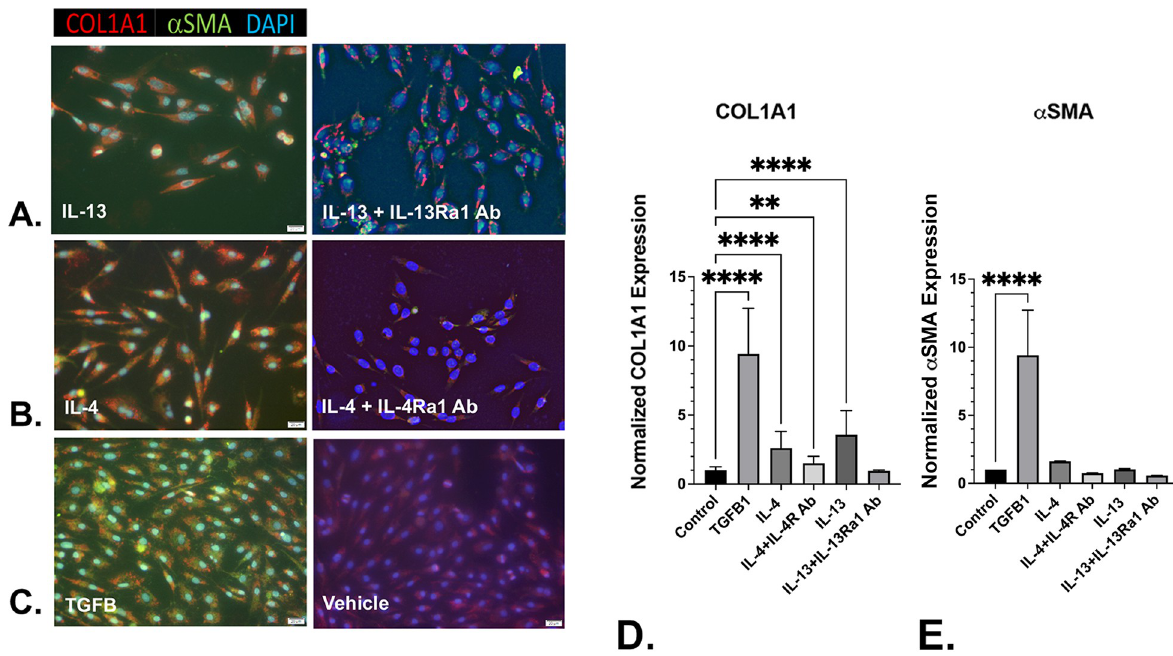
Fig 5. IL-4 and IL-13 promote COL1A1 and α SMA co-expression and upregulate receptors inhibitors repress IL-4 and IL-13-mediated prostate myofibroblast phenoconversion. N1 prostate fibroblasts were treated with 20 ng/ml of IL-13 or IL- 4, or 4 ng/ml TGF β 1 (positive control) for 48 hr, then co-immunostained for COL1A1 (PE-cy5-conjugated Ab, red), α SMA (fluorescein-conjugated Ab, green), or counterstained with nuclear-specific DAPI (blue), and the images merged. N1 cells treated with IL-13 ( A ), IL- 4 ( B ), or TGF β 1 ( C ), demonstrated significantly ( D ) increased expression COL1A1 in vitro compared to vehicle-treated cells, but only cells treated with TGF β 1 demonstrated significantly increased expression of α SMA. Pre-treatment with antibodies against the cognate receptors of IL-3 and IL-14, respectively, repressed the induction of COL1A1 protein expression ( A, B, D ), demonstrating the specificity of the cellular response to interleukin treatment. N1 cells treated with TGF- β 1 exhibited a morphological change from a spindle-like shape to a more stellate shape consistent with the myofibroblast phenotype ( C ), whereas cells with IL-13 ( A ) or IL-4 ( B ) retained a spindle-like morphology suggesting a lack of myofibroblast differentiation. Images were captured and photographed using fluorescence microscopy on an EVOS 1 FL Auto system at 20X magnification. Fluorescence quantitation was assessed using Image-Pro Plus 7 imaging software. The number of cells evaluated for COL1A1 expression were 495 (control), 578 (TGF β ), 889 (IL-4), 224 (IL4 +IL4R Ab), 761 (IL-13), and 96 (IL-13+IL-13R α 1 Ab). The number of cells evaluated for α SMA expression were 495 (control), 578 (TGFB), 56 (IL- 4), 142 (IL4+IL4R Ab), 172 (IL-13), and 98 (IL-13+IL-13R α 1 Ab) (S5 Fig). Significant differences between paired comparisons are indicated as � p < .05; �� p < .01; ��� p < .001; ���� p < .0001.